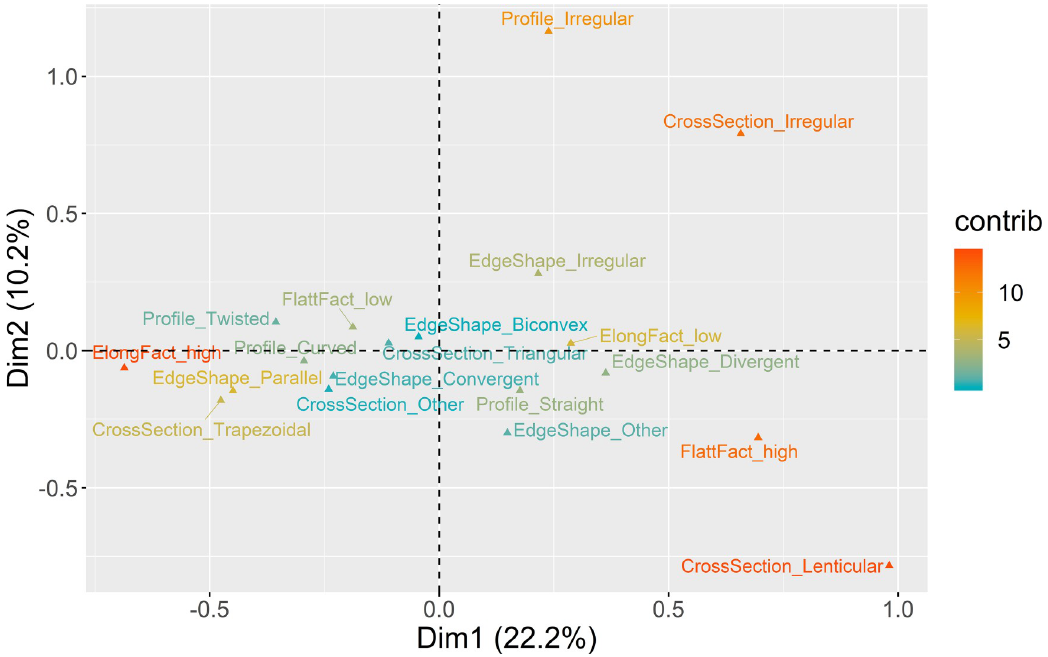
Fig 9. Multiple correspondence analysis plot (first two dimensions) for Dorsal surface convexity. The color ramp represents the contribution (in %) of the variable categories to the definition of the dimensions.